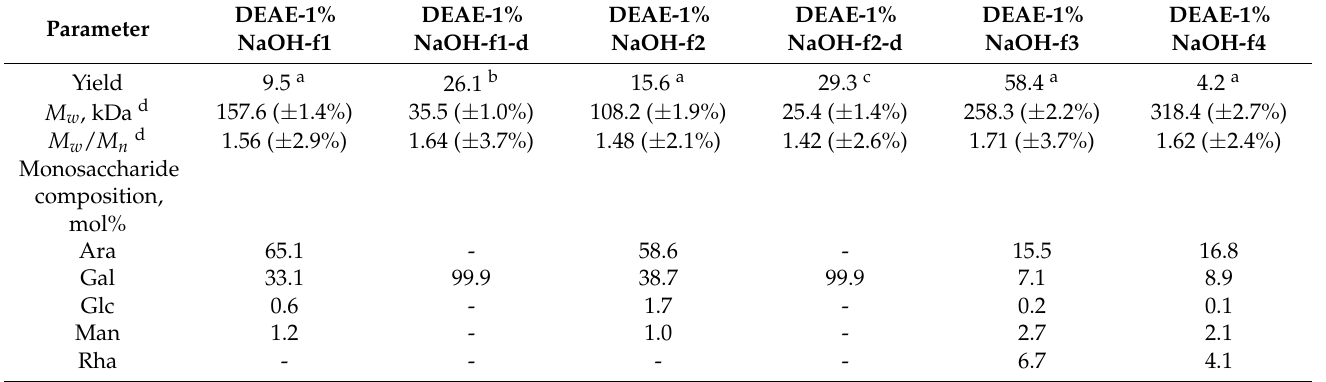
Figure 4. Characteristics of DEAE–sepharose fast-flow gel fractions of DEAE-1% NaOH-f1 (f1), DEAE-1% NaOH-f2 (f2), DEAE-1% NaOH-f3 (f3), and DEAE-1% NaOH-f4 (f4): ( a ) elution profiles on GP-HPLC; ( b ) UV–Vis spectra of 1 mg/mL water solutions; ( c ) FTIR spectra. Table 6. Yield, molecular weight, monosaccharide composition, phenol content, and phenolic acid content after alkaline hydrolysis and linkage analysis of DEAE–sepharose fast-flow gel homogenic polymers and degradation